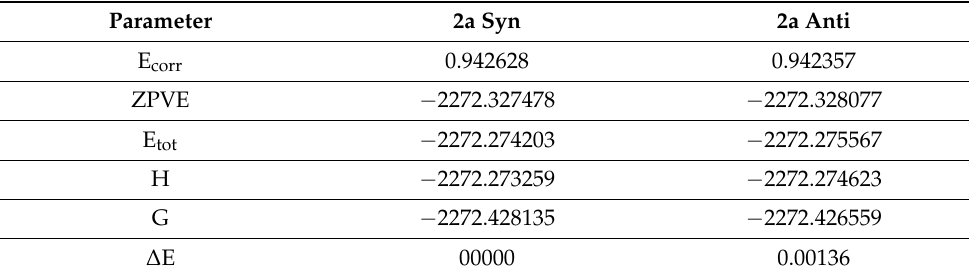
Table 4. Thermal parameters (Hartree/Particle) of both conformers of 2a .